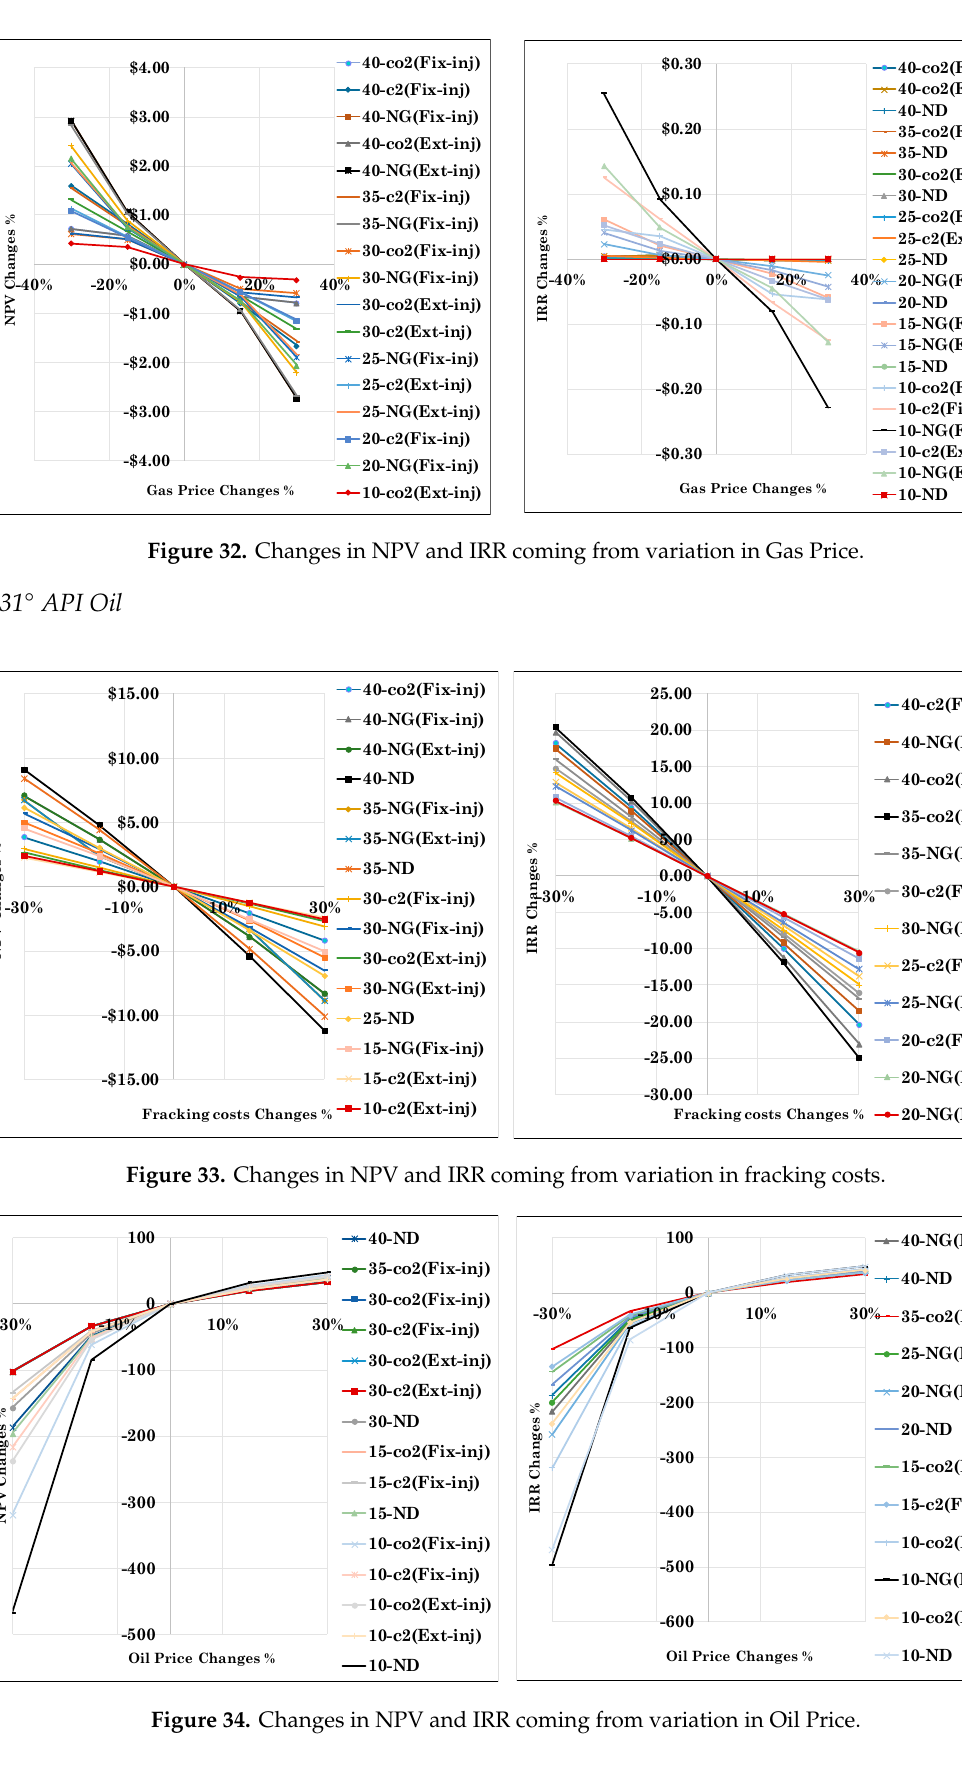
Figure 35. Changes in NPV and IRR coming from variation in Gas Price 5. Conclusions CO 2 preferentially mobilizes the lighter oil components and reservoir residual oil becomes heavier with time. The molecular selectivity of CO 2 leads to the retention of intermediate and heavy components in residual oil. Natural gas has higher MMP compared with CO 2 and pure ethane. Because miscibility is achieved quicker than with CO 2 and NG, ethane is capable of effectively mobilizing the light, intermediate and even heavier hydrocarbon components. The poor performance of natural gas is related to incomplete miscibility and inefficient mobilization of crude oil. To observe how the IFT changes in each scenario, one grid block is selected and the IFT trend versus time is plotted for all cases. Though the volumes of injected solvents are identical for all scenarios, pure ethane has led to highest oil recovery for the same production time and operation conditions. Comparison between three injection gases of C 2 , CO 2 and NG, the ethane-EOR results in terms of RF are the most favorable followed by CO 2 and NG. Constant and extended C 2 , CO 2 and NG injection modes are compared along with the primary production recovery. Number of fracture stages is also studied in terms of profitability and are included in economic analysis. By sensitivity analysis of uncertainties on the key field development